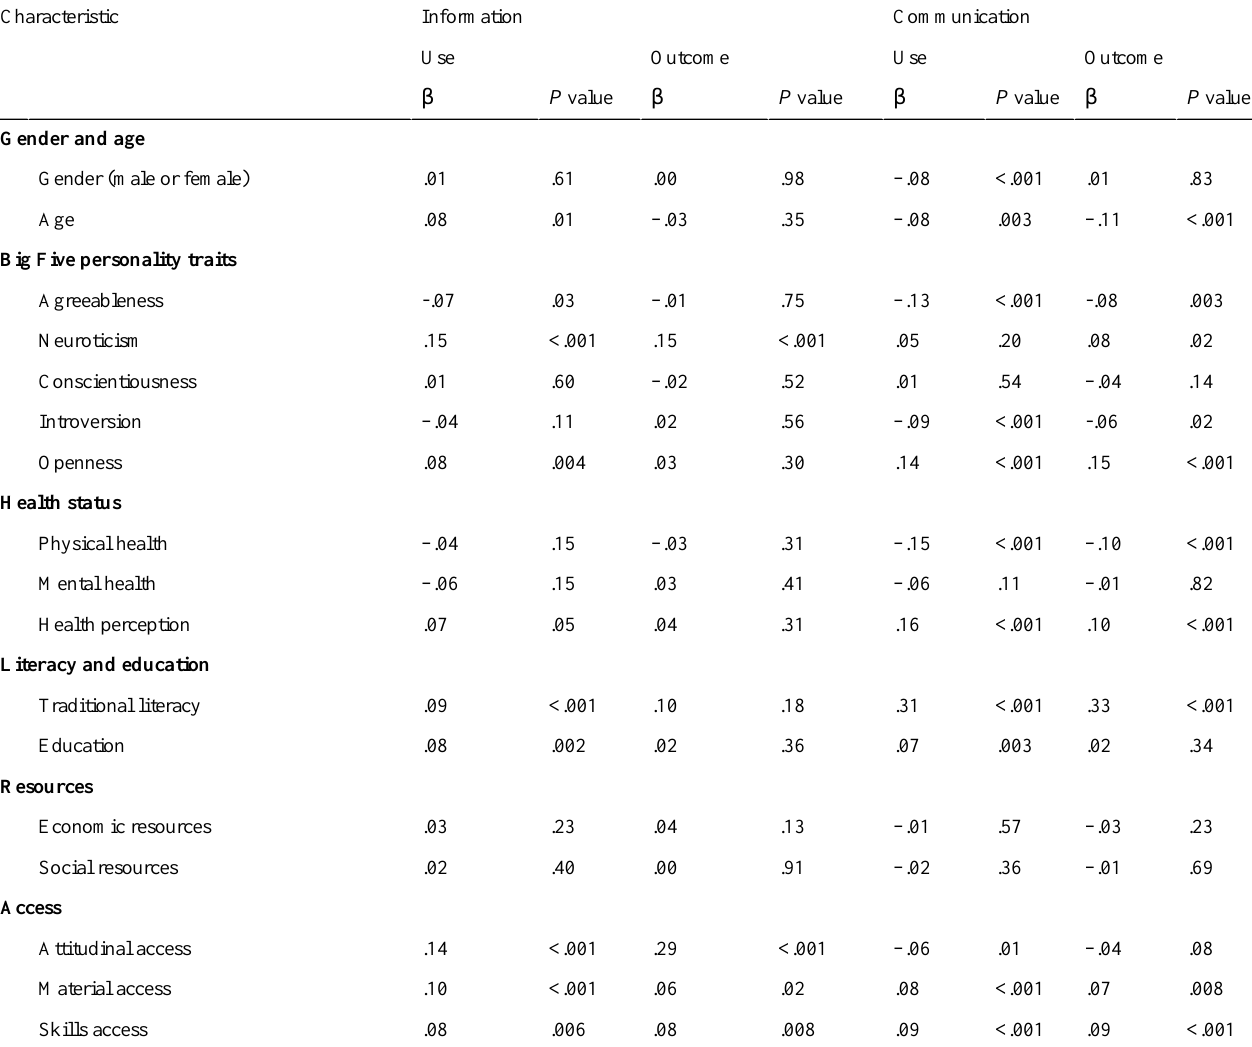
Table 3. Hierarchical regression analysis summary for coronavirus disease–related internet uses and outcomes (Model 1).